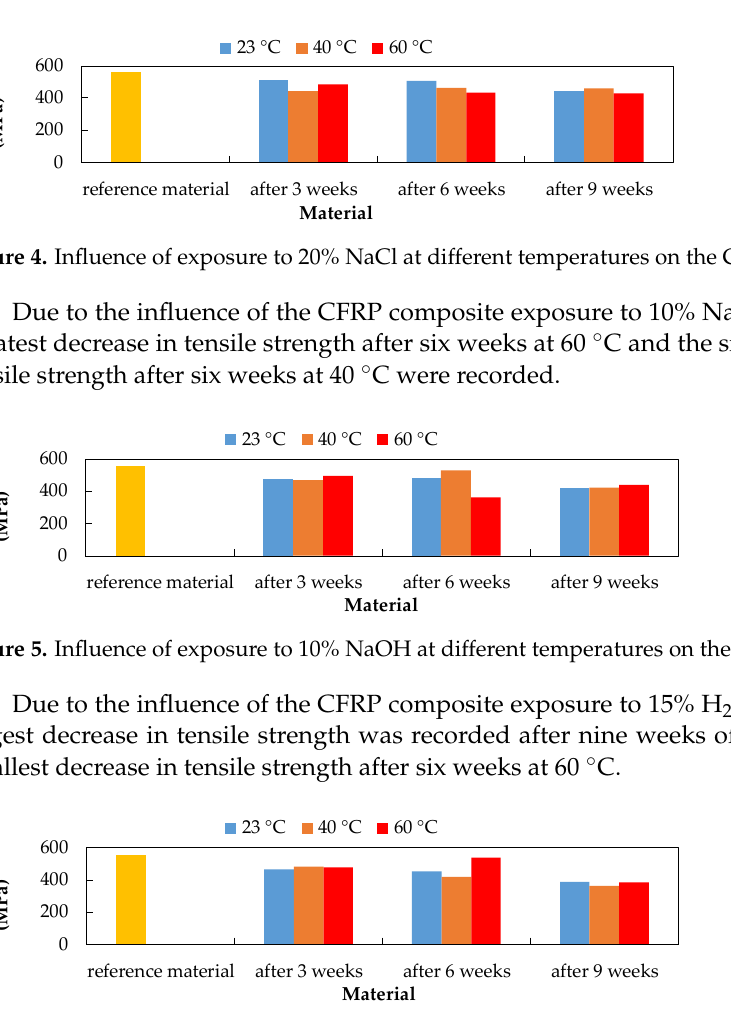
Figure 6. Influence of exposure to 15% H 2 SO 4 at different temperatures on the CFRP composite. The typical experimental stress ‐ strain curves of the CFRP composite immersed in 20% NaCl, 10% NaOH and, 15% H 2 SO 4 at 60 °C for three, six and nine weeks can be seen in Figure 7.